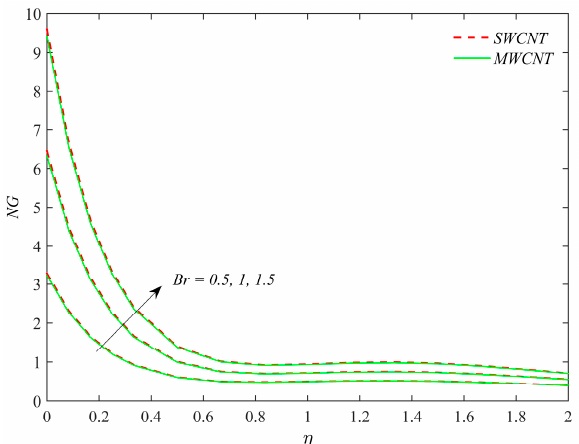
Figure 24. The variation of the entropy optimization NG for the case of SWCNT and MWCNT versus the similarity variable for the distinct values of the material parameter K .